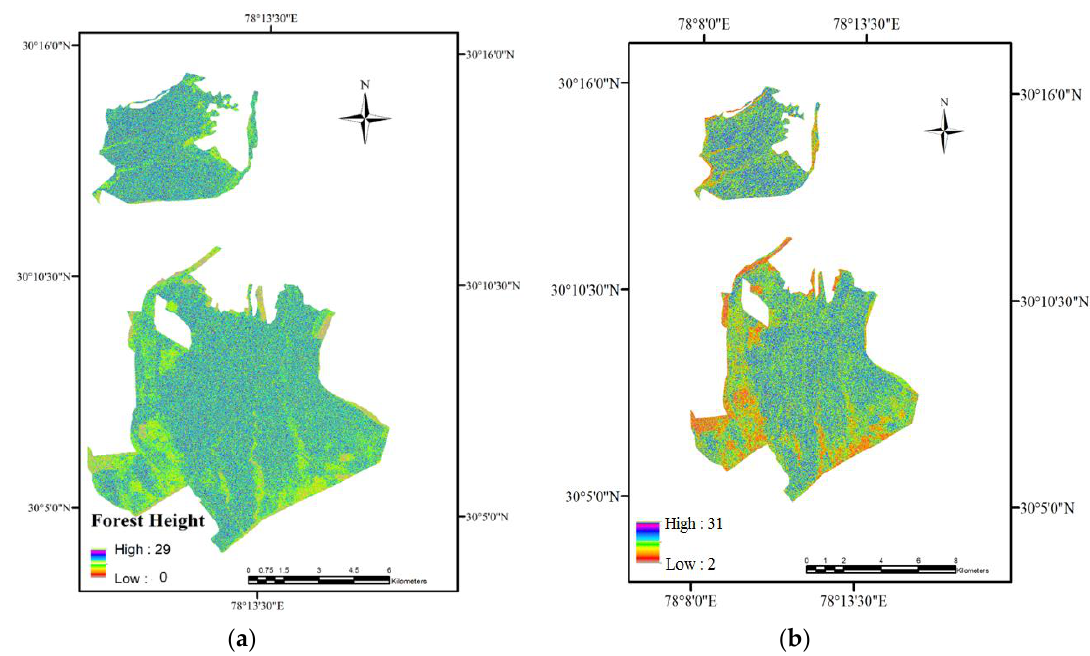
Figure 10. RADARSAT-2 inversion-based forest height for the Barkot and Thano forest ranges using ( a ) the TSI model and ( b ) the CAI model.